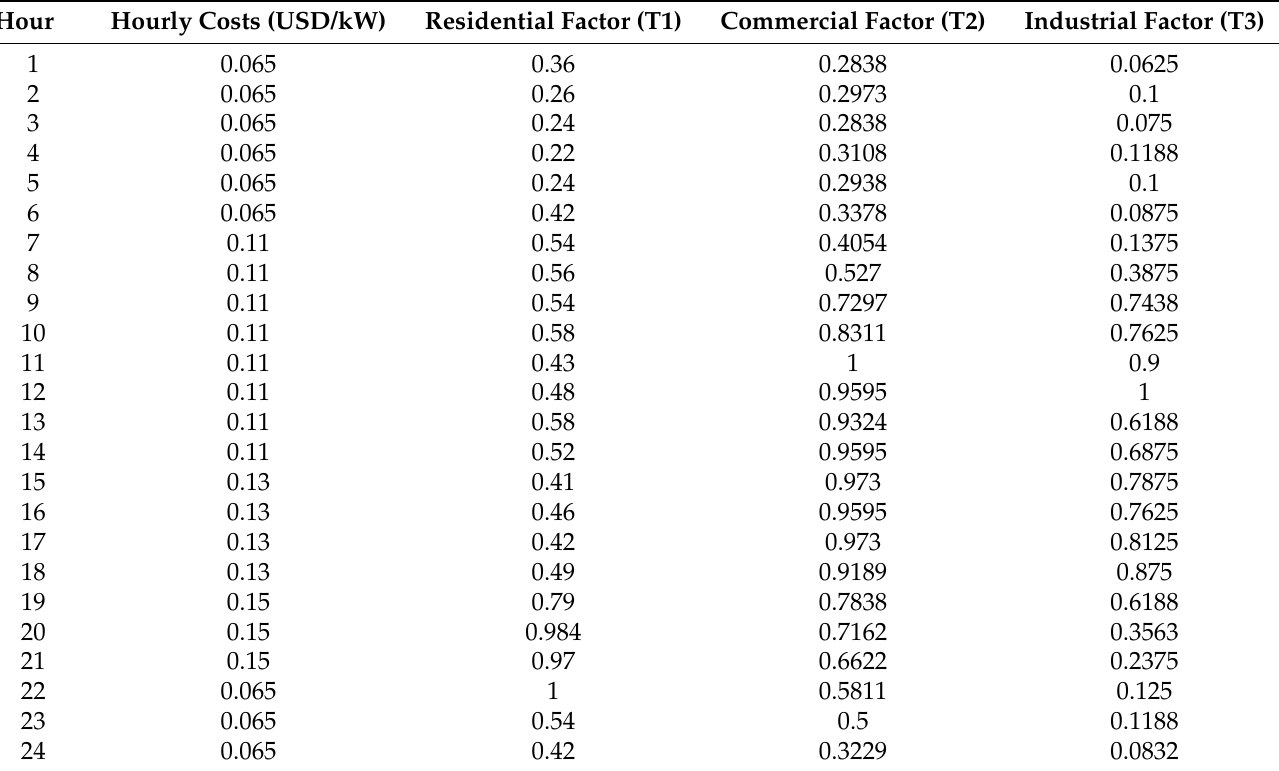
Table 3. Hourly costs and load profile (24 h).